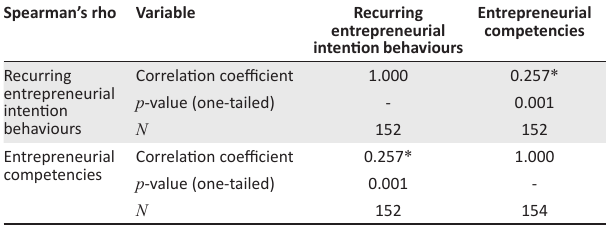
TABLE 4: Results of Spearman’s rank-order